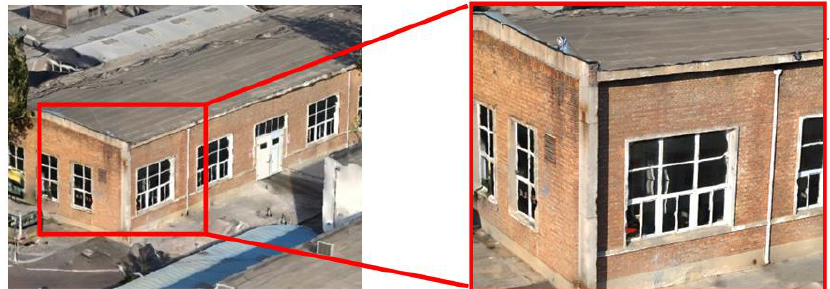
Figure 8 The model constructed by the oblique photogrammetry and the ground